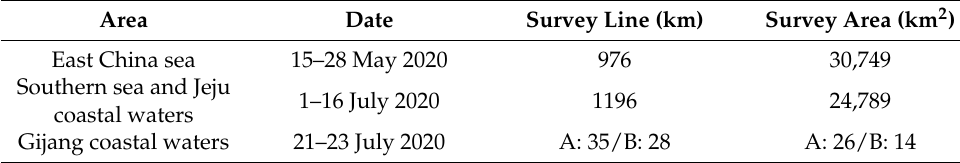
Figure 1. Acoustic survey sites in the East China Sea. Table 1. Survey area and